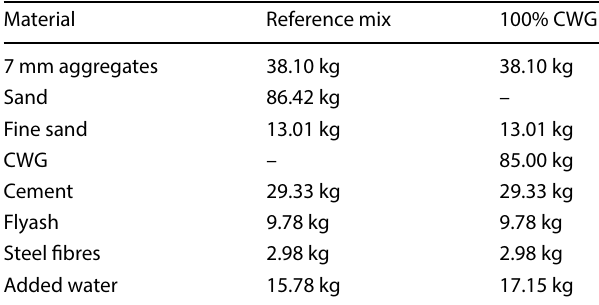
Table 3 Mix design for the reference and the 100% sand-replaced mixes for preparing 85 litres of shotcrete Material